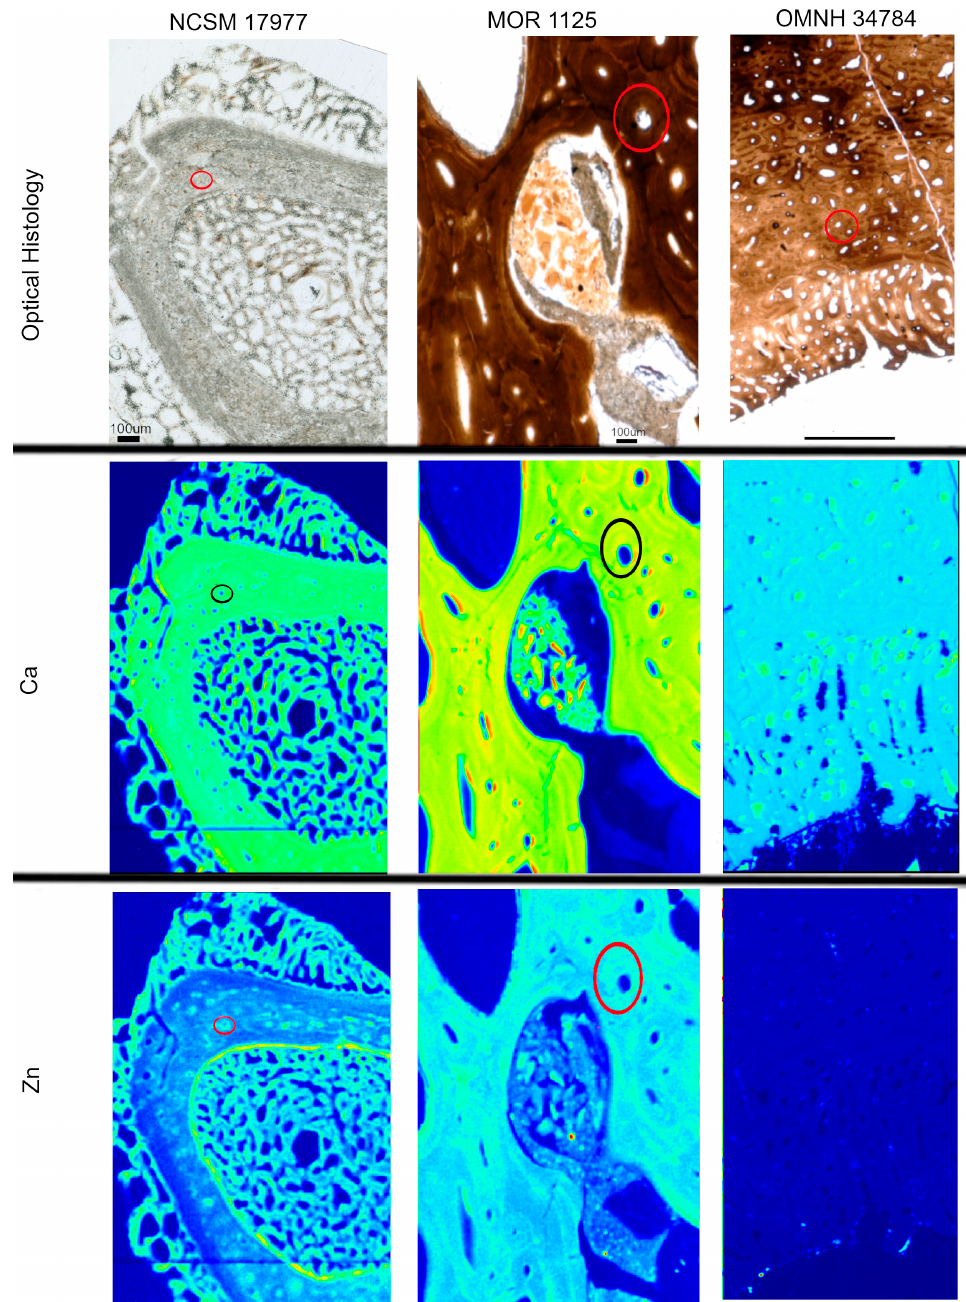
Figure 3. Optical histology and XRF maps taken from beamline 2-3 of Ca and Zn taken for all specimens. Warmer colors correspond to higher concentrations. Secondary osteons are highlighted in Ca and Zn (example osteon highlighted by circles) in NCSM 17977 and MOR 1125. OMNH 34784 shows uniform distribution of Zn, with concentrated Ca in pores between tissues.